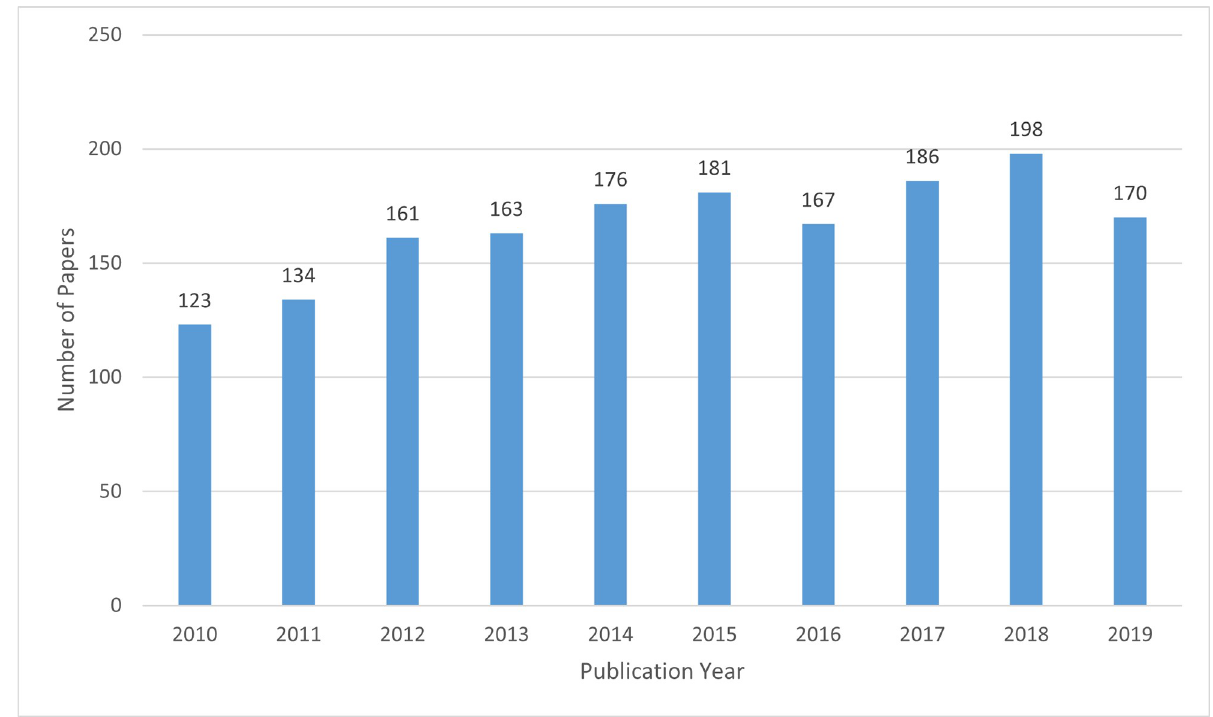
Fig 2. Canadian contributions to research on NTDs, 2010–2019 inclusive, by year. NTD, neglected tropical